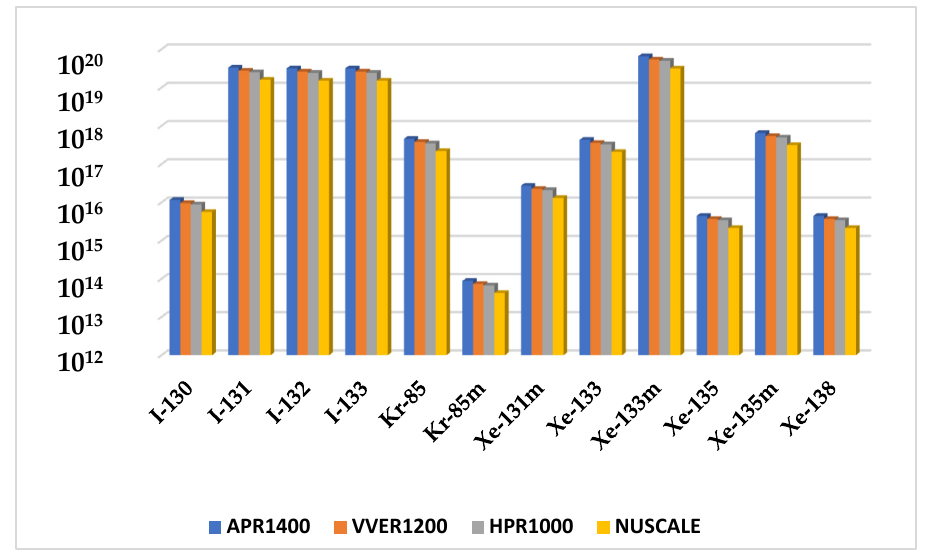
Figure 4. Comparison of fuel handling accident source term activity inventory.